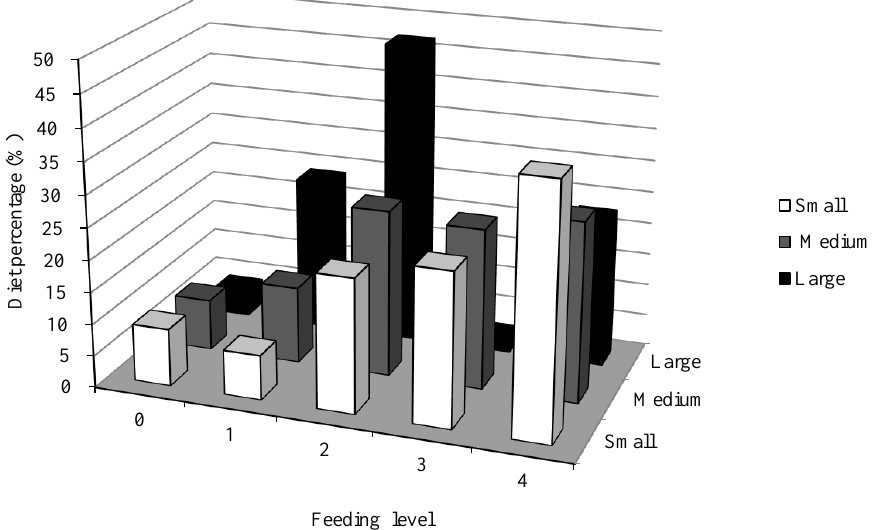
Figure 7. Ontogenetic shift in the feeding level of Acanthocybium solandri in the Western and Central Pacific Ocean.